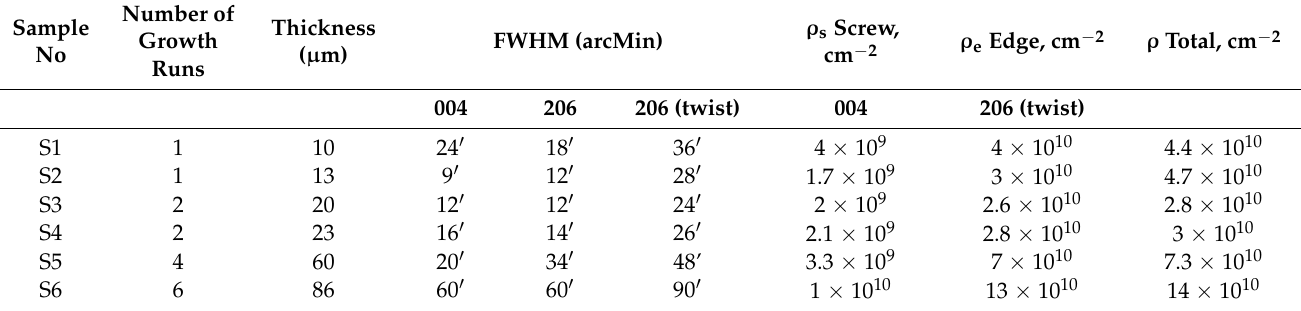
Table 1. Structural characteristics of κ -Ga 2 O 3 films grown by HVPE on (GaN